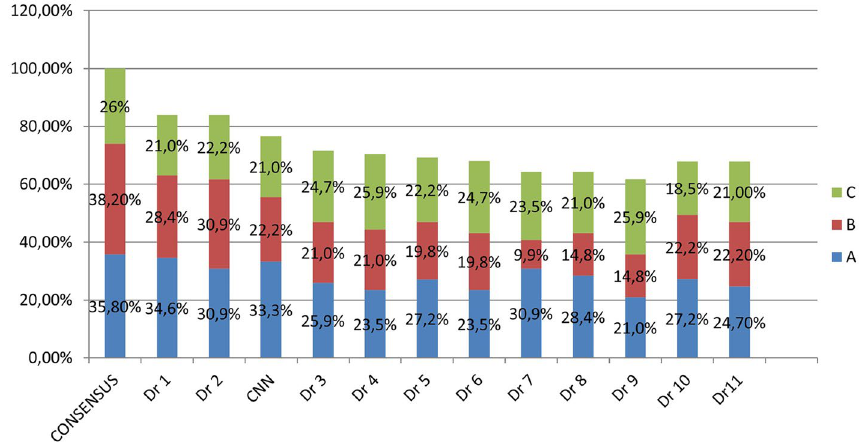
Figure 5. According to the consensus list, CNN achieved a %76.5 total classification performance. Only Dr1 (%84) and Dr2 (%84) had more achievements than CNN. CNN surpassed 9 of 11